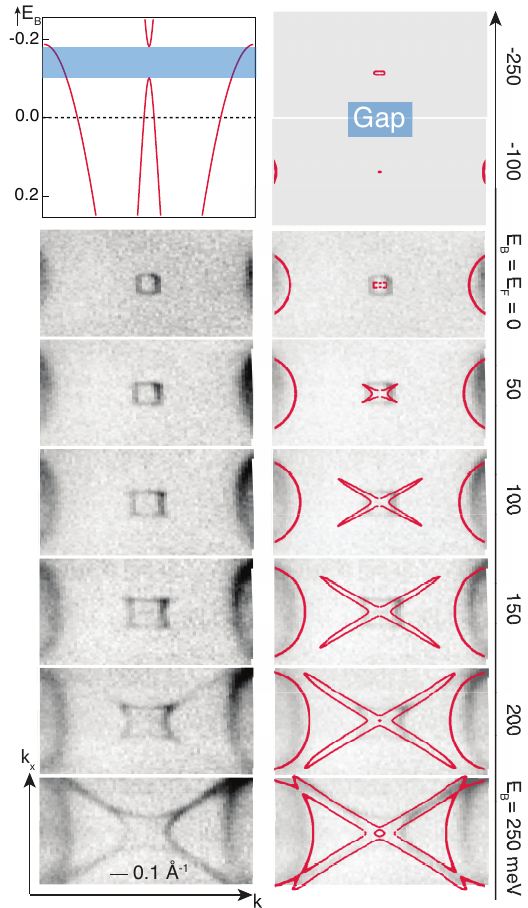
Figure A1: Constant energy contours around the Y-point from ARPES and TB calculations Top-left panel: dispersion of the Y states along Γ − Y direction from the TB calculation; Bottom- left panel: constant energy ARPES maps around the Y-point at the binding energies indicated; Right panel: Constant energy contours of the bands from the TB calculations, integrating 5 meV above and below the energy shown, is superimposed on the top of ARPES